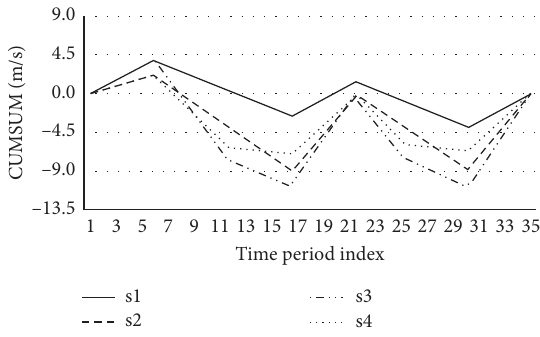
Figure 6: CUSUM charts of the first 4 station interval.